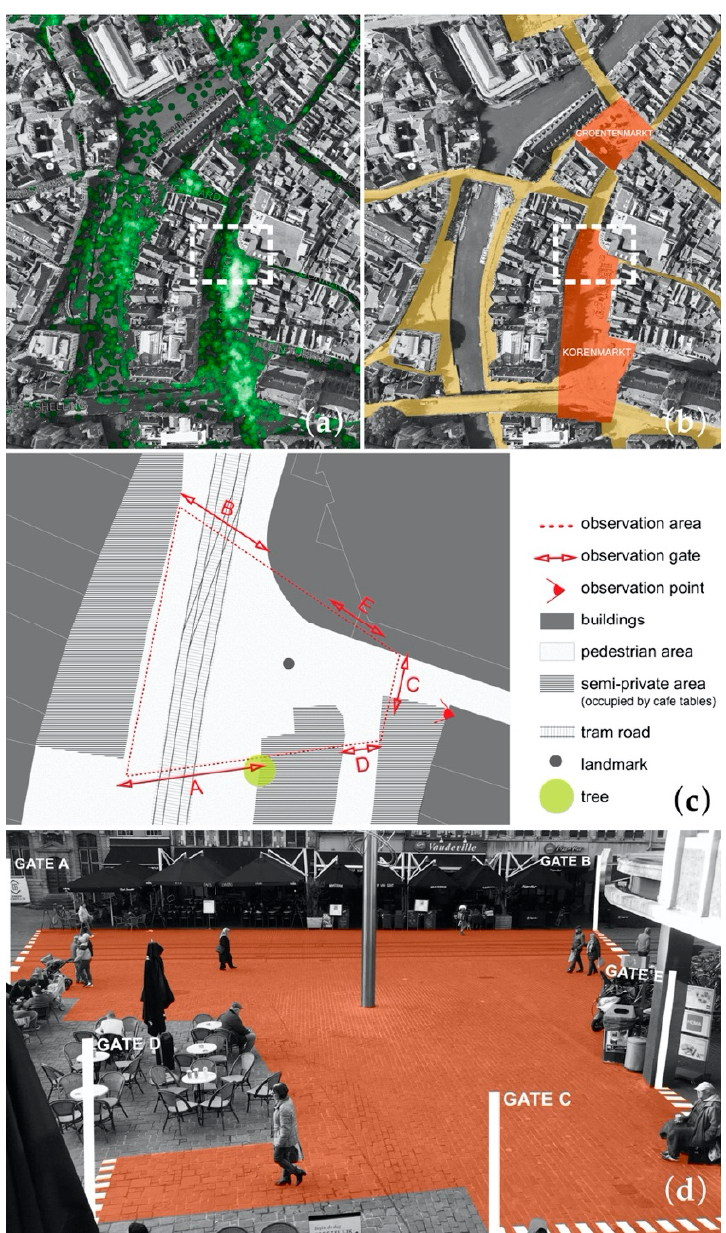
Figure 3. ( a ) Superposition of the six billion tweets map [59] on the Korenmarkt Square made by the authors, ( b ) pedestrian route network, public squares, and observation area (dashed white line), ( c ) map of the observation area with the boundaries of the camera perspective, and ( d ) the view from the observation point with the designated observation gates (original figure by the authors).